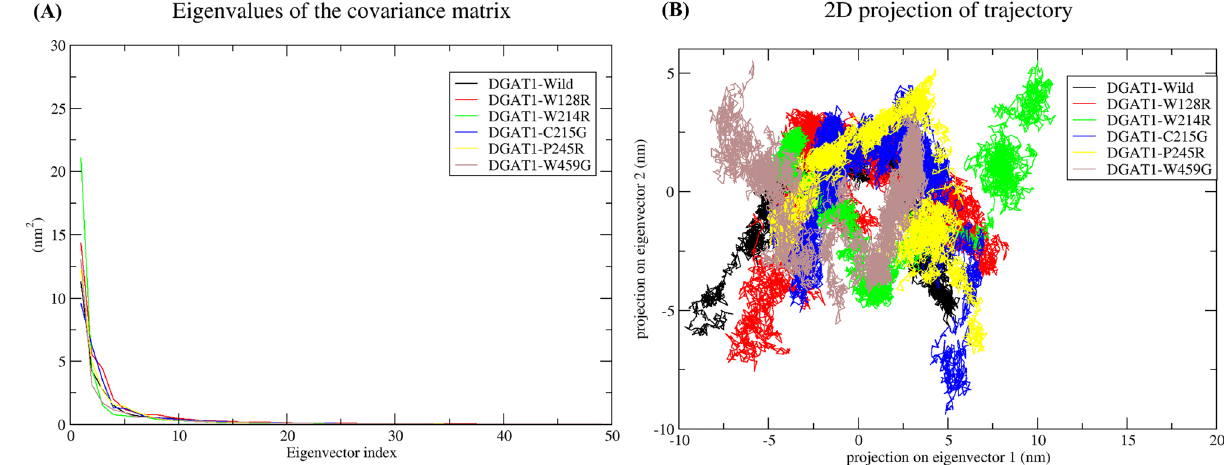
Figure 7. Principal component analysis using molecular dynamics simulation data. ( A ) First 50 eigenvectors against eigenvalue of the DGAT1-wild type and its variants. ( B ) First two eigenvectors depicting the projection of protein motion in phase space for DGAT1-wild type and its